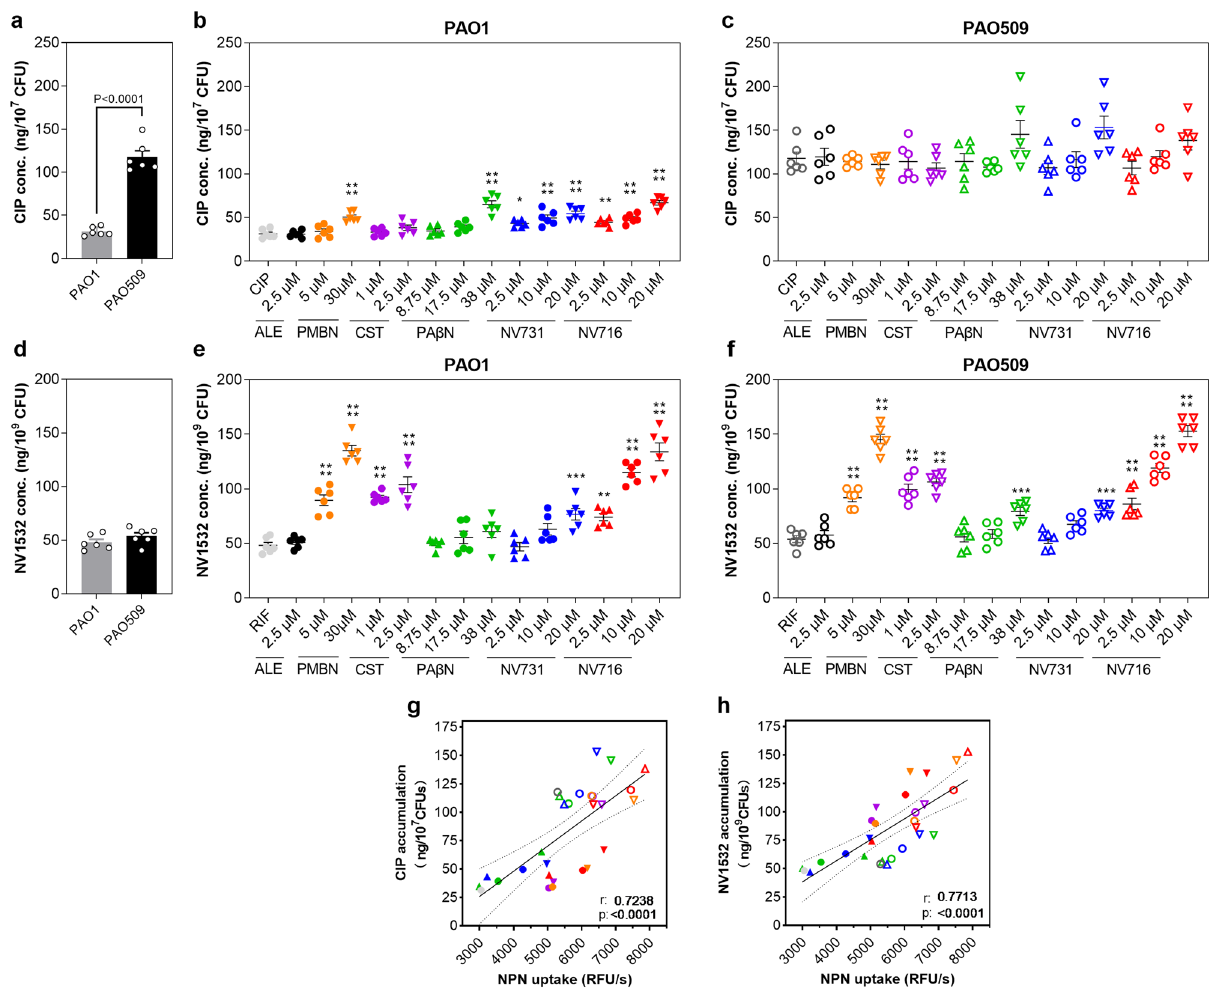
Fig. 4 Accumulation of antibiotics in PAO1 and PAO509. Cipro fl oxacin or rifampicin analog NV1532 were used alone ( a , d ) or combined with potentiators in PAO1 ( b , e ) or PAO509 ( c , f ). Potentiators were added at the indicated concentrations (alexidine [ALE]; polymyxin B nonapeptide [PMBN]; colistin [CST]). All data are mean ± SEM (triplicates from three independent experiments). Statistical analysis: Left-panels: Two-tail Student ’ s t test for comparison of antibiotics alone in PAO1 and PAO509; other panels: one-way ANOVA with Dunnett ’ s post-hoc test for comparison of antibiotics alone and combined with each potentiator: * p < 0.05; ** p < 0.01; *** p < 0.001; **** p < 0.0001. Correlation between the accumulation of cipro fl oxacin ( g ) or NV1532 ( h ) in bacteria and the outer membrane permeability as assessed by the fl uorescence signal of NPN (see Fig. 3 f – i ). The Pearson correlation coef fi cient r and the p values are shown on each graph. The plain and dotted lines correspond to the linear regression with its 95% con fi dence